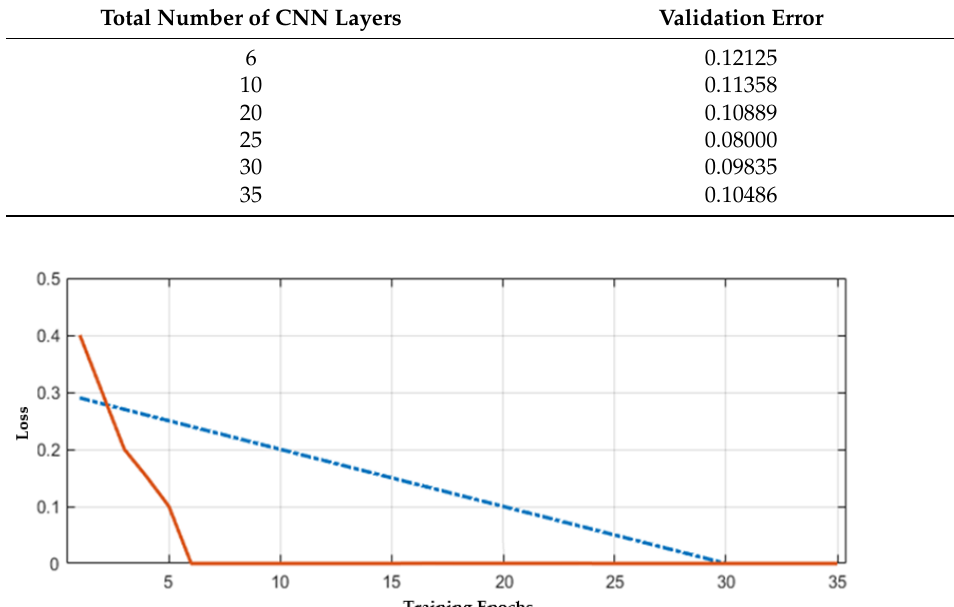
Table 5. Validation error for layers selection in the proposed CNN model.